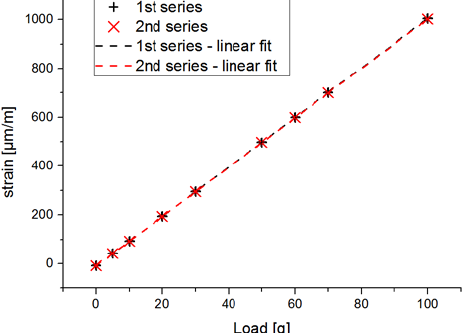
Figure 9. Diagram of the measured strain and the applied load in grams of a full bridge